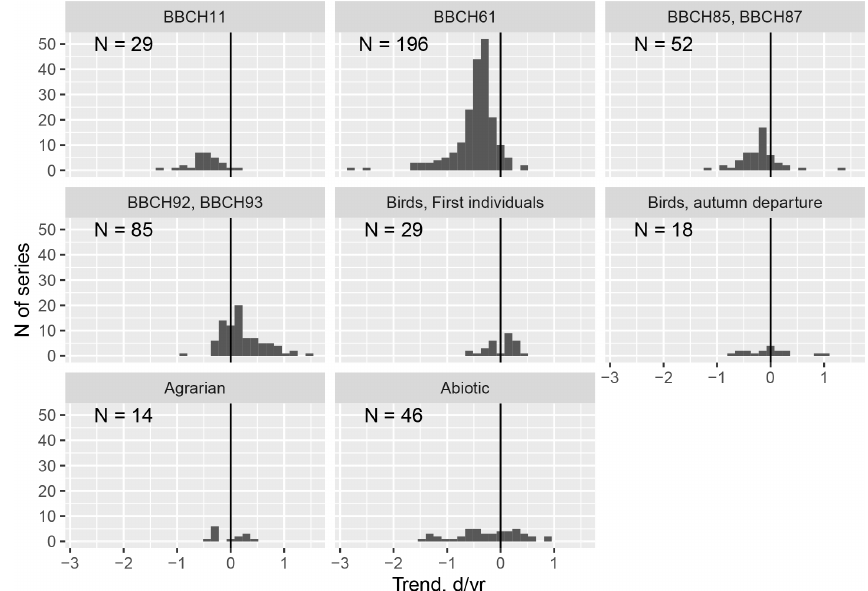
Figure 9. Phenological changes in Latvia in the period from 1970 to 2018. Phenological phases are grouped into taxonomic groups: sep- arately distinguishing developmental phases of plants such as leaf unfolding, flowering, ripening, and leaf colouring. N is the number of observation series used. Data series – data from one observation station with at least four single-phase observations before 1987 and four after